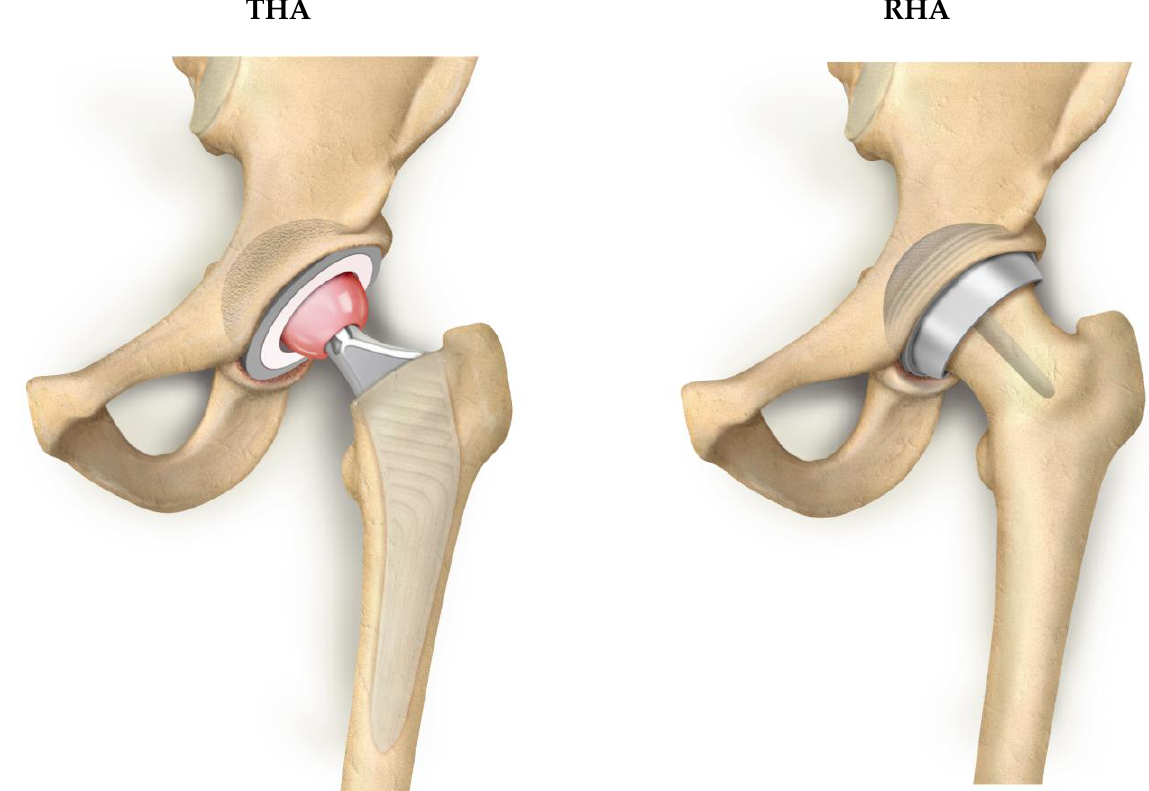
Figure 1. Illustration of total hip arthroplasty (THA) and resurfacing hip arthroplasty (RHA).